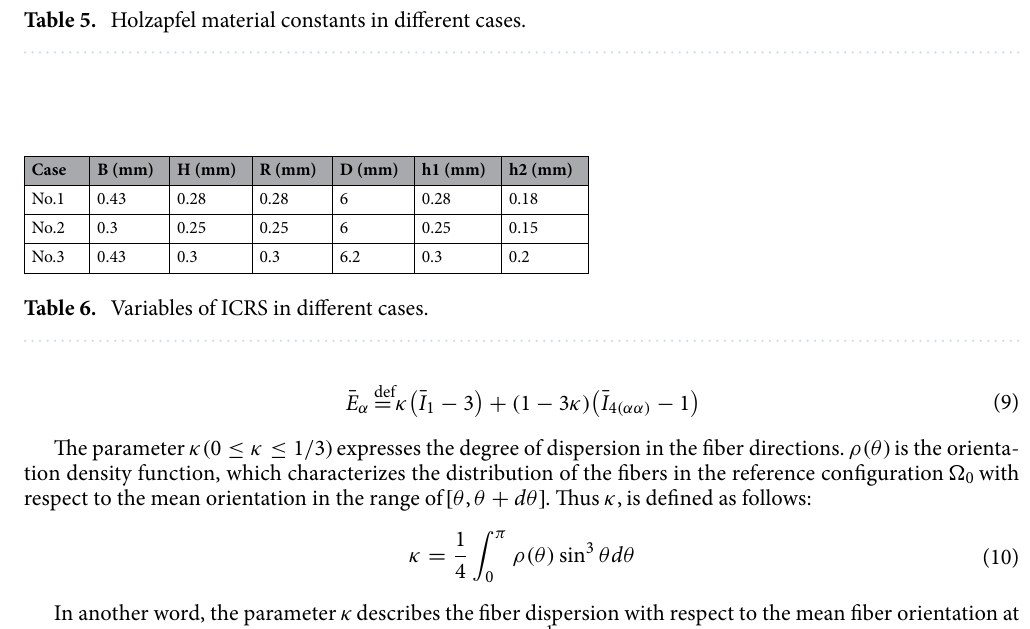
Table 6. The angle of the two ICRS bases with a horizontal axis was set at 30 degrees. The assumed ICRS variables were listed in Table 6, and there are shown in Fig. 9b–d. To present a comparative study, the KeraRing dimen- sions were selected similarly to the corresponding MyoRing characteristics in the respective scenarios. The ICRS was modeled as linear elastic and isotropic, with a Poisson’s ratio of 0.3 and a modulus of elastic-